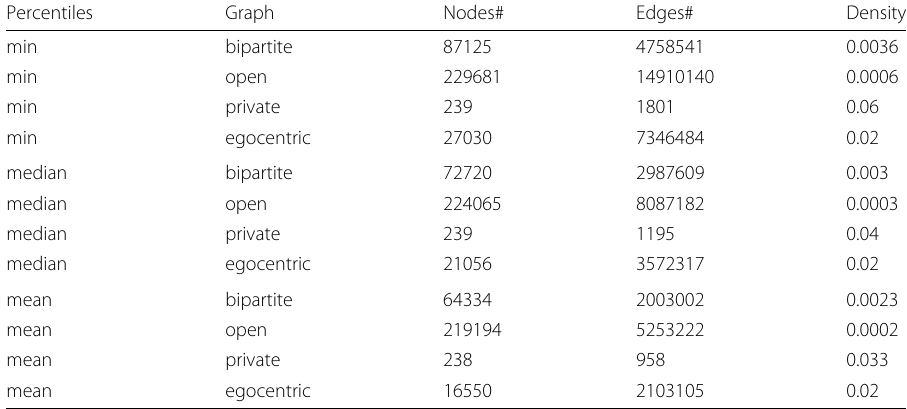
Table 21 Global measures values of the proteins-metabolites networks according to the data base STITCH and to combined score percentiles